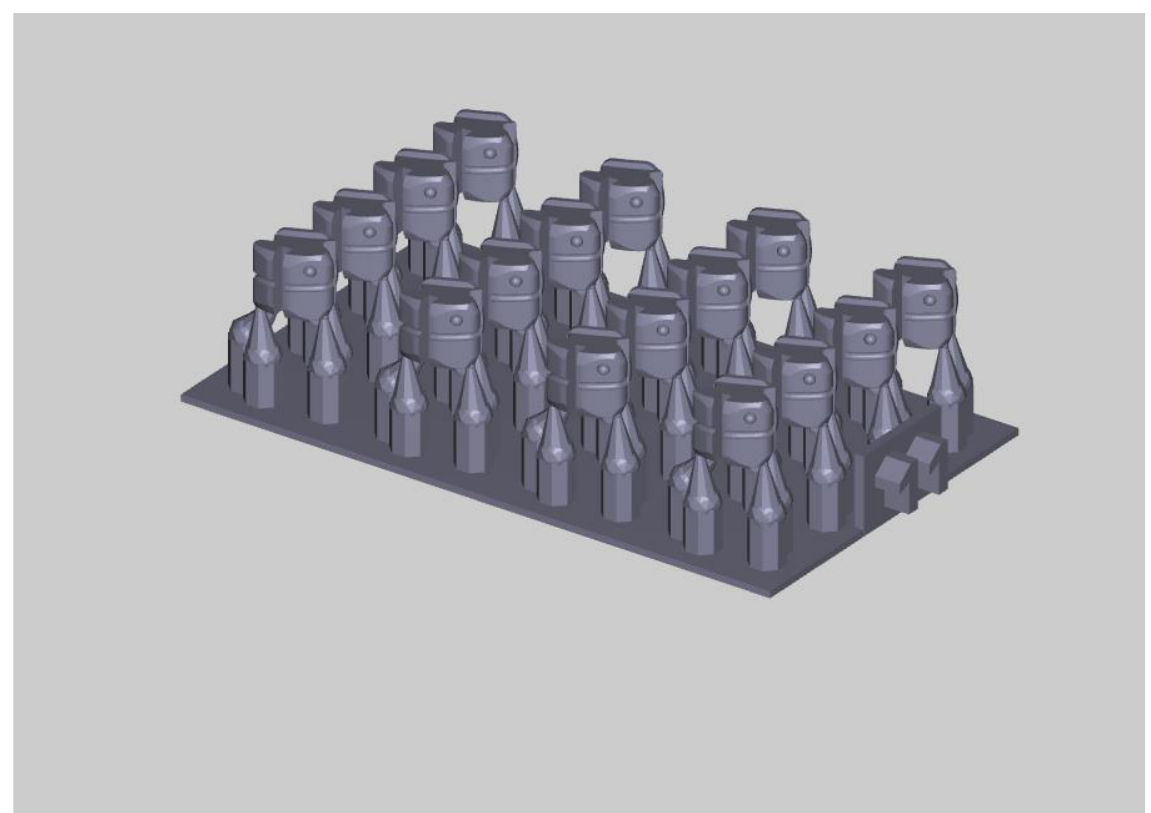
Figure 1. Stl files with digitally designed supports.